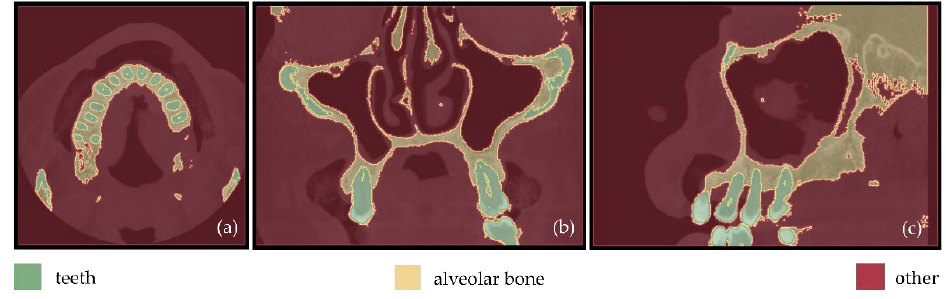
Figure 14. Segmentation results for Experiment 4 after the application of the “Grow from seeds” method, superimposed over CBCT slices in the axial plane ( a ), the coronal plane ( b ), and the sagittal plane ( c ).